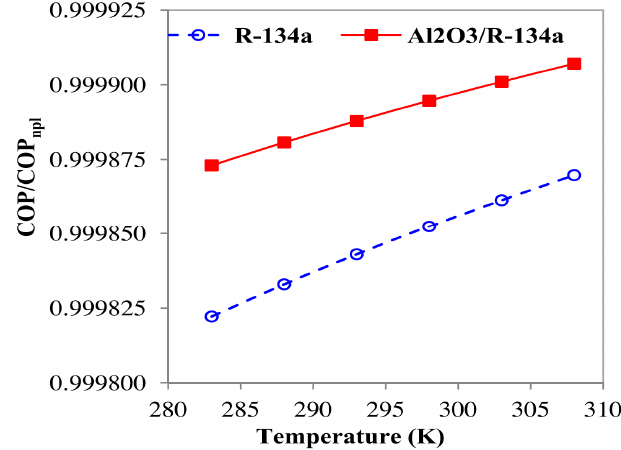
Figure 12. Effect of the viscosity of Al 2 O 3 /R ‐ 134a nanorefrigerant on COP at different temperatures (npl: no pressure loss) [39].